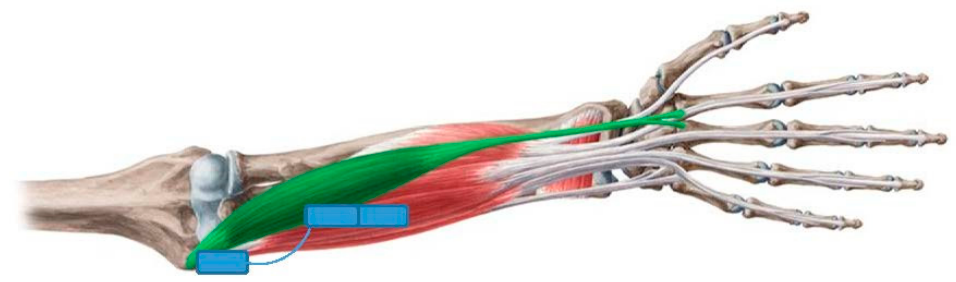
Figure 6. Positioning of the EMG sensors of the human hand.